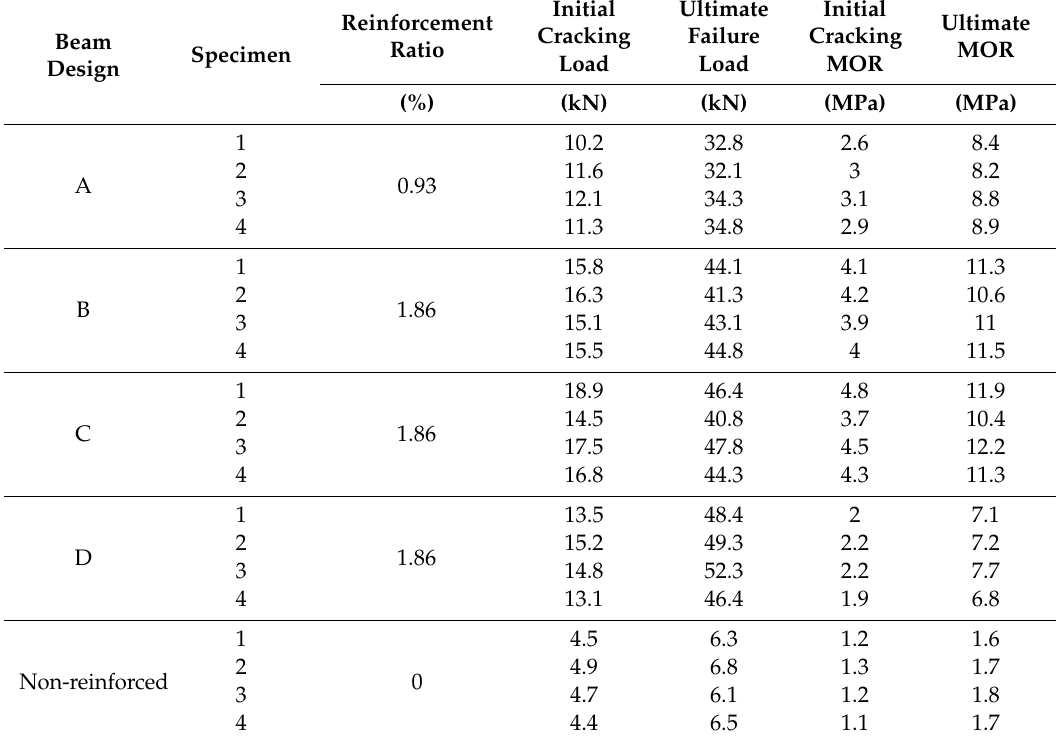
Table 7. Summary of results obtained for the four-point flexural test of concrete beams.